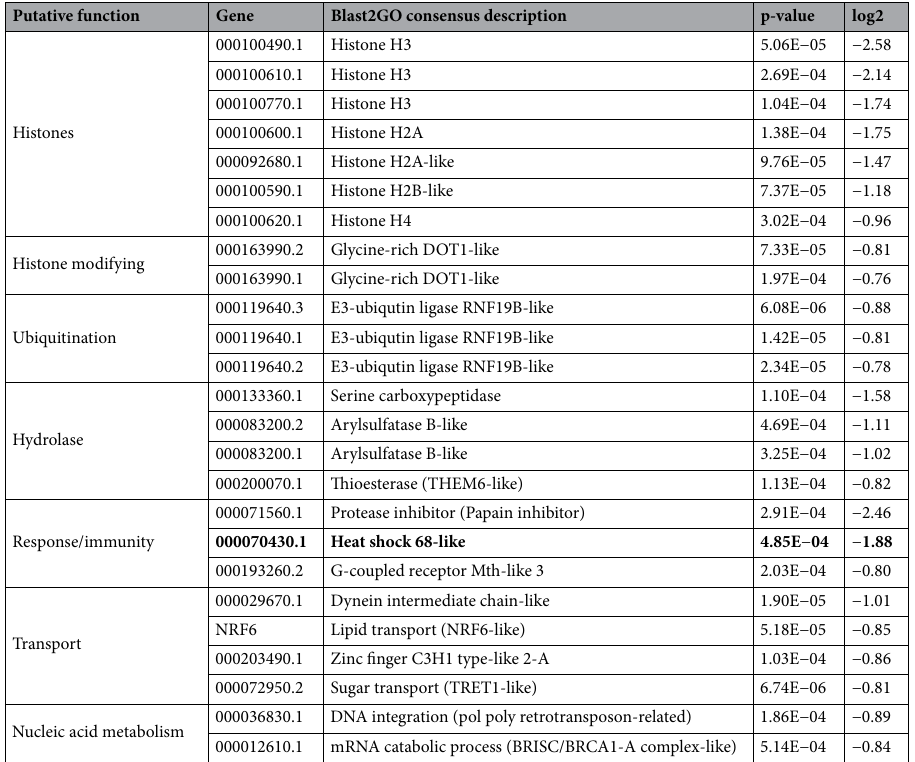
Table 3. Most highly down-regulated M. persicae transcripts that were characterized [33 uncharacterized genes were down-regulated (see Supplemental Table S2)] in aphids carrying PLRV compared to controls. DEGs determined by adjusted p value < 0.1 and described by Blast2GO. Gene ID corresponds to MYZPE13164_ G006_v1.0_XXXXXXXXX.X found on AphidBase.org. Regulation of bolded transcripts were validated in a separate experiment.